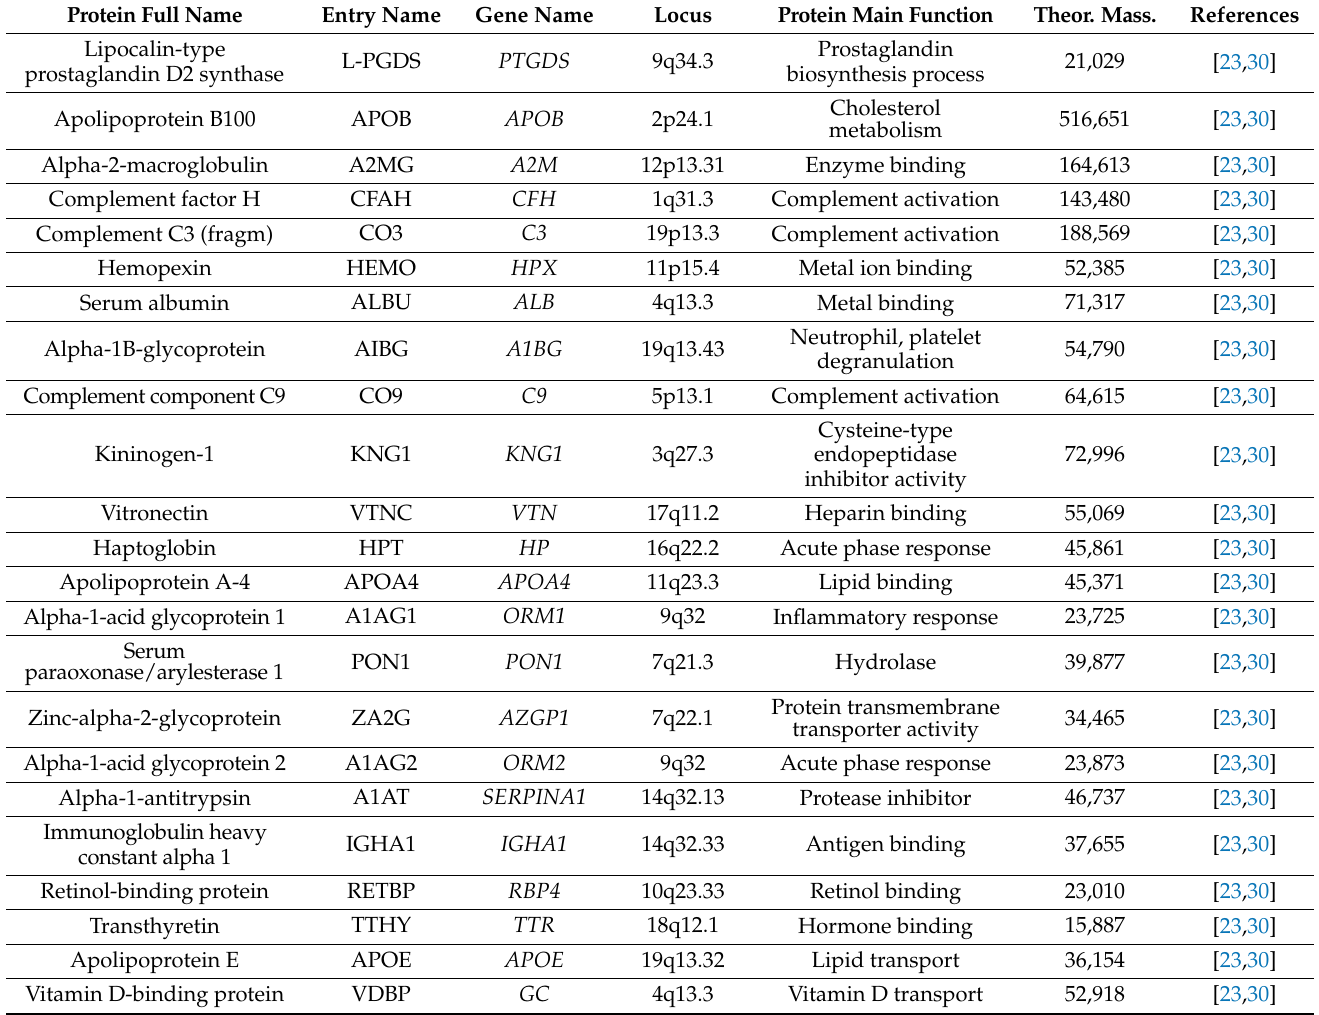
Table 1. Candidate serum proteomic biomarkers of medication-overuse